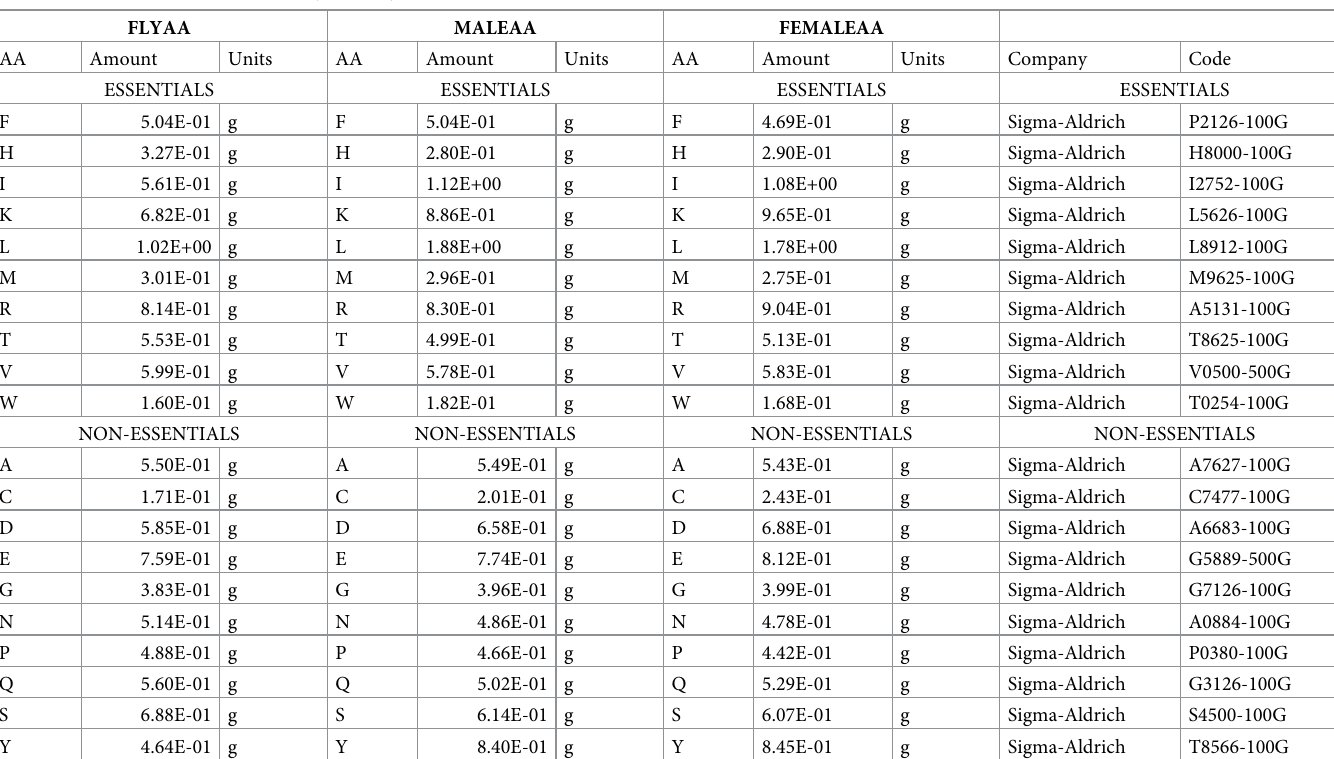
Table 3. Amino Acid Stock Solutions (1000